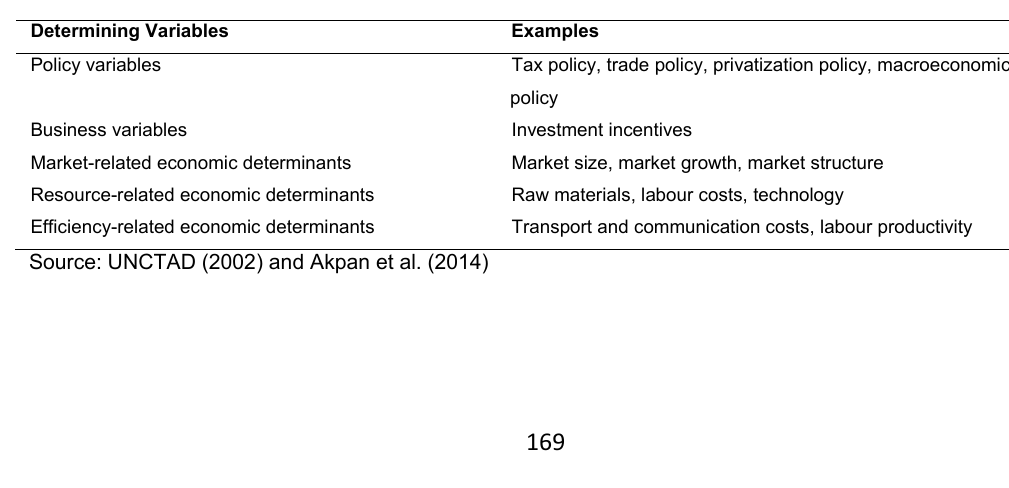
Table 2: UNCTAD's Classification of FDI